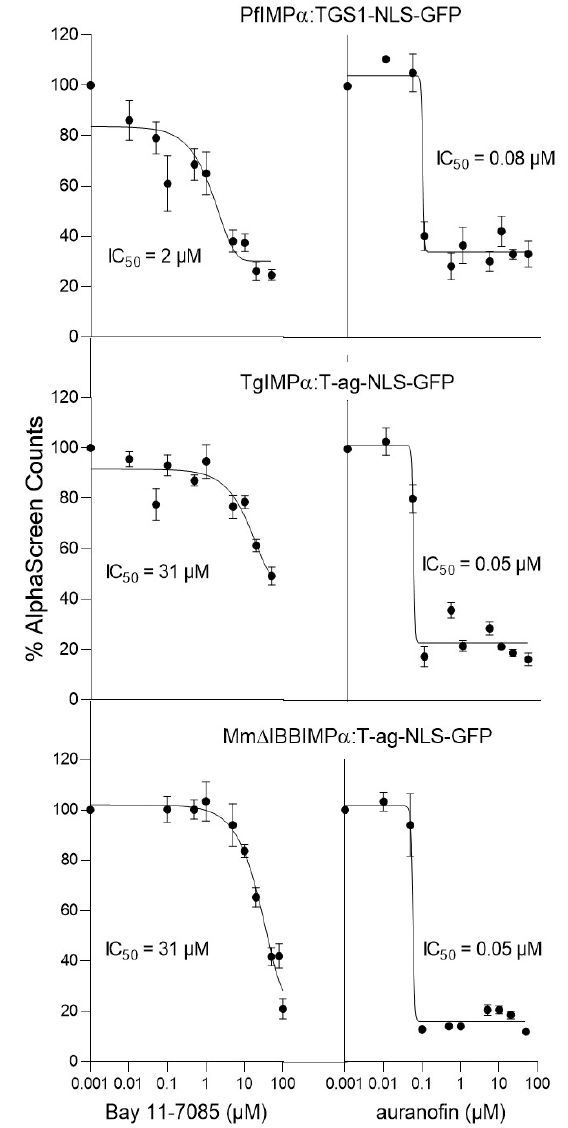
Figure 3. Bay 11-7085 specifically inhibits PfIMP α -TGS1-NLS interaction at low micromolar concen- tration, whereas auranofin is a general inhibitor of IMP α :NLS interactions. AlphaScreen technology was used to determine the IC 50 for inhibition by Bay 11-7085 and auranofin binding of IMP α s (5 nM) to NLS (30 nM). Data represent the mean ± SEM ( n = 4) from a single experiment, from a series of three independent experiments (see Table 3 for pooled data).